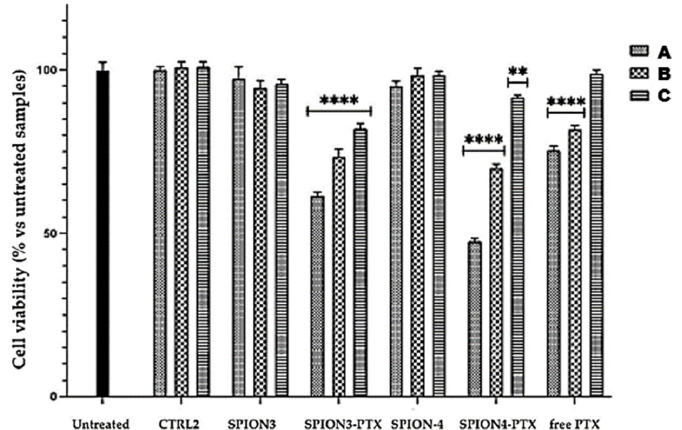
Figure 5. Cell viability of 4T1 cells incubated with SPIONs and free PTX at different concentrations (i.e., A, B, and C respectively correspond to 50, 10, and 1 µg/mL of vector for NP samples and 6.25, 1.25, and 0.13 µg/mL of PTX for free PTX samples). Normalized vs. untreated sample. Note: **** p < 0.0001, ** p < 0.01 vs. untreated sample, n = 4 (two-way ANOVA with Dunnett’s test).